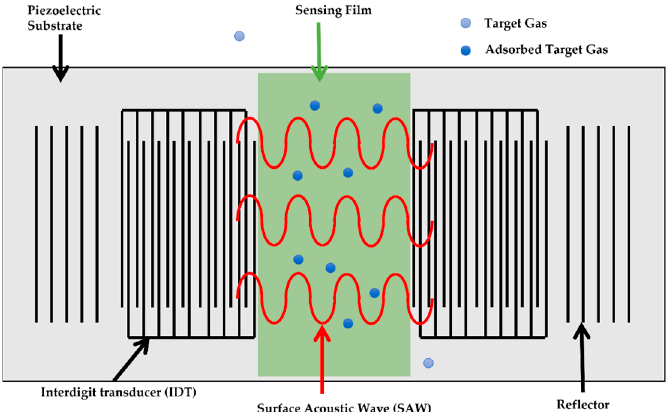
Figure 1. Surface acoustic wave chemical sensor.